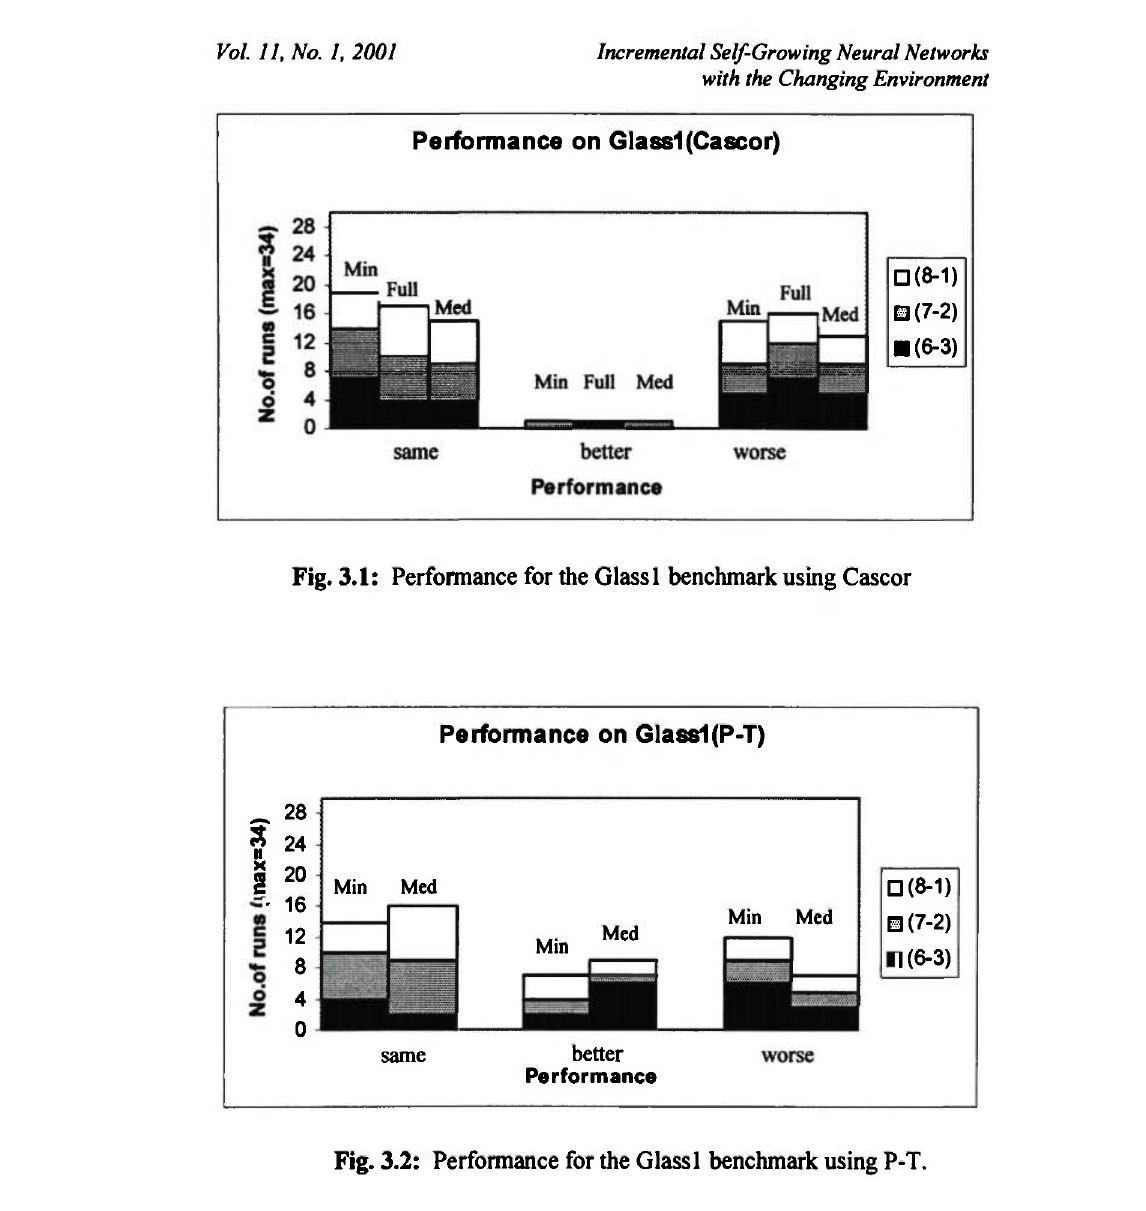
Fig. 3.2: Performance for the Glass 1 benchmark using